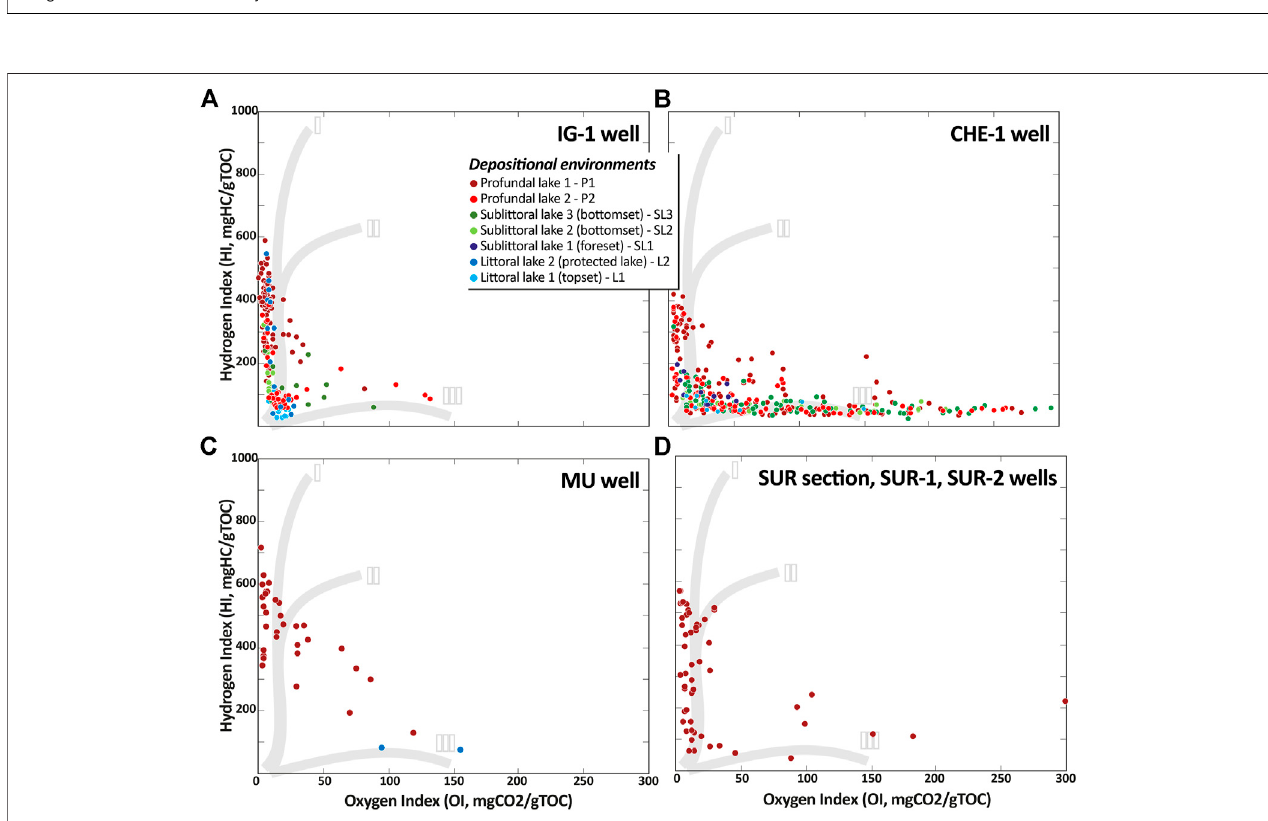
FIGURE 11 | Pseudo-van Krevelen diagrams displaying HI and OI values for the studied section samples depending on the depositional environments. (A) In the IG-1 well samples, the more distal facies display the highest HI values, whereas environments submitted to high sediment supply and oxidation processes show lower values. (B) In the CHE-1 core samples, the facies distribution is not as marked as for the IG-1 well, with more oxidized samples. (C,D) In the MU and SUR cores and section, the environment is only lacustrine (either littoral or profundal) with minimal sediment supply and samples mostly display high HI-low OI values.